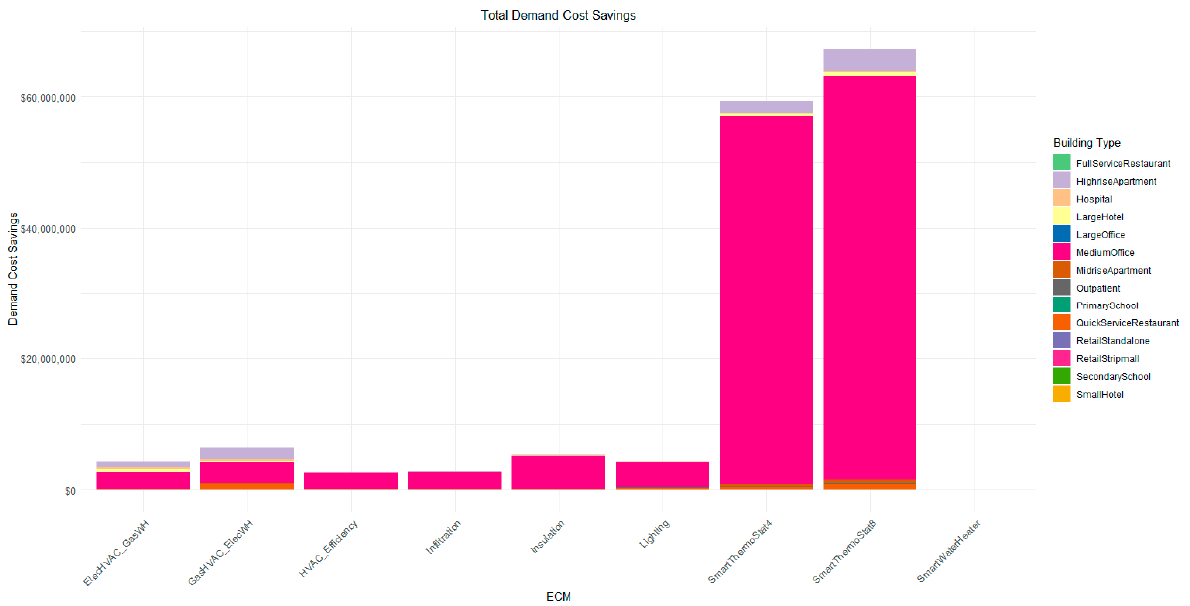
Energies 2021 , 13 , x FOR PEER REVIEW